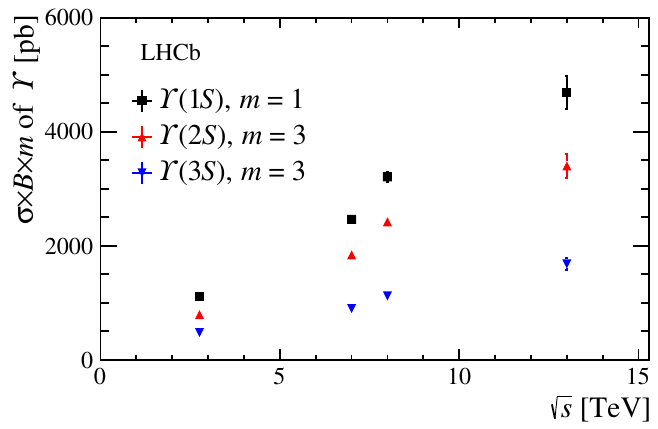
Figure 4 . The production cross-sections multiplied by dimuon branching fractions integrated over 0 < p T < 15 GeV =c and 2 : 0 < y < 4 : 5 versus centre-of-mass energy of pp collisions for the (cid:7) (1 S ) (black solid squares), (cid:7) (2 S ) (red upward triangles) and (cid:7) (3 S ) (blue downward triangles) states. Each set of measurements is o(cid:11)set by a multiplicative factor m , which is shown on the plot. Statistical and systematic uncertainties are added in quadrature.